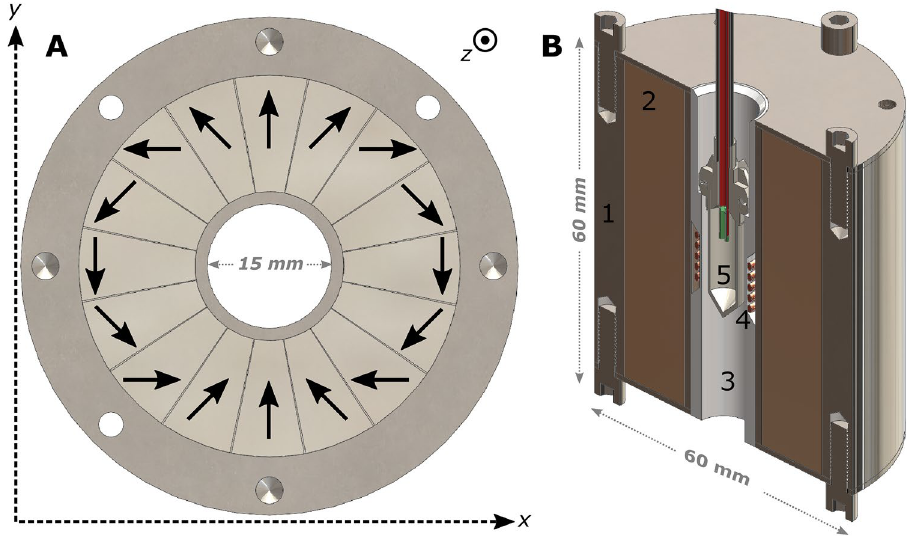
Figure 1. Drawings of the 16 elements Halbach magnet array. The arrangement and orientation of the different magnetic units is reported; the arrows represent the magnetization axis of the different elements ( A ). A simplified section view of the probe bottom part shows the sample position inside the Halbach magnet. The most important elements are indicated with numbers: stainless steel chassis of the Halbach magnet (1); SmCo magnetic material (2); PTFE coil former (3); solenoidal NMR coil (4); vial/sample cup